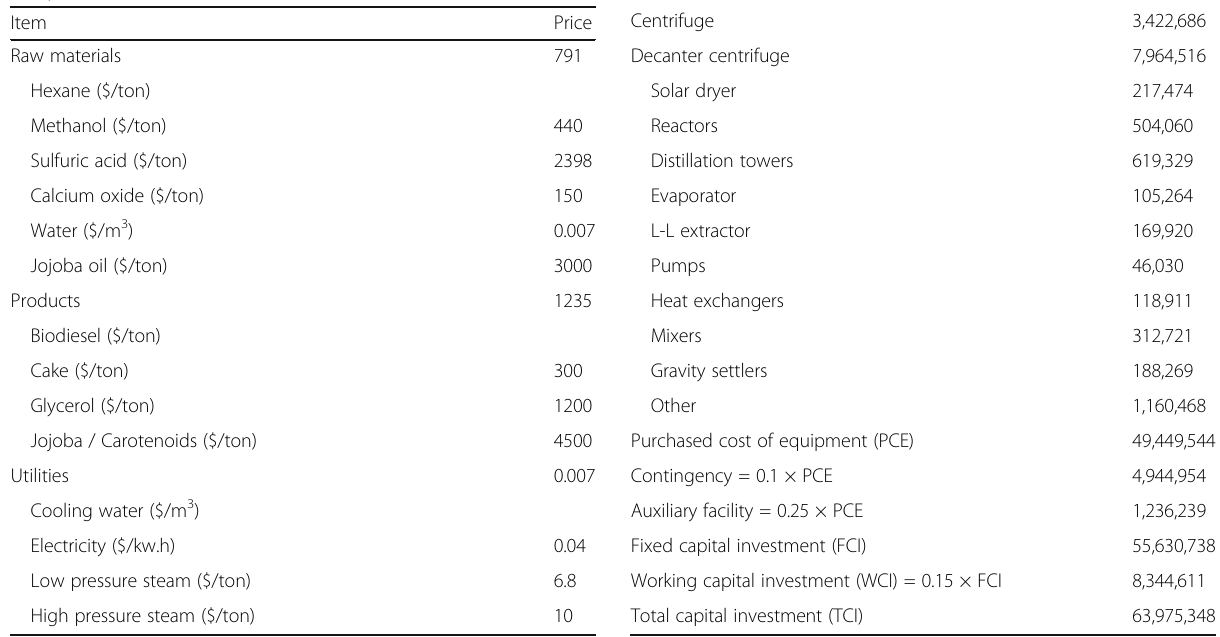
Table 4 Costs of raw materials, utilities, and products used in the process